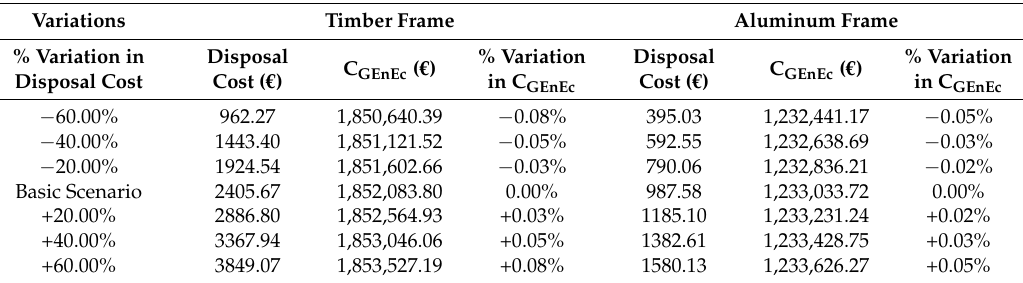
Table 13. Sensitivity analysis with decreased/increased disposal costs.